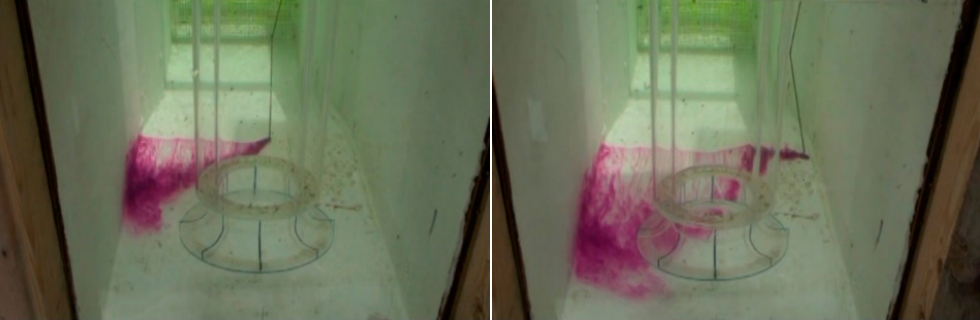
Figure 8. Injecting dye across the width of the pump bay shows a uniform and stable approach flow.